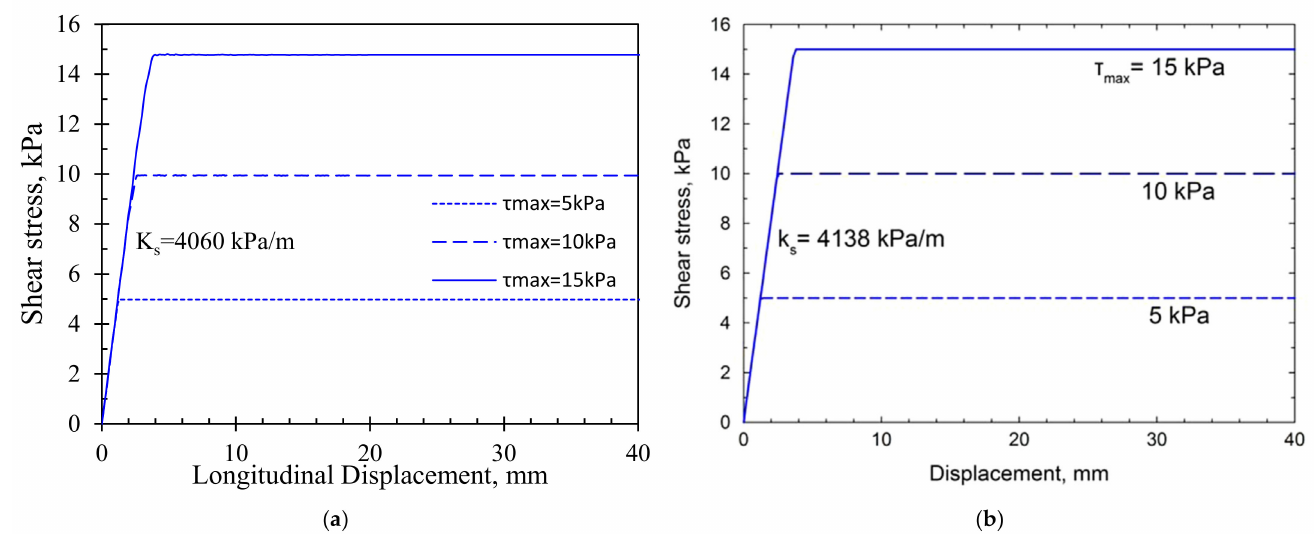
Figure 4. Shear stress–displacement relationship at the soil–pipe interface for friction coefficients of 0.2, 0.3, and 0.4. ( a ) This study, ( b ) Vazouras et al. [39].